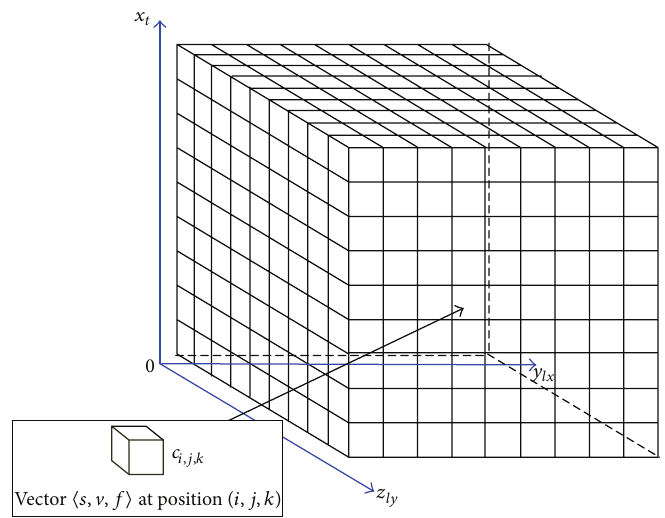
Figure 2: ITS computational domain projects heterogeneous traffic data into three-dimensional